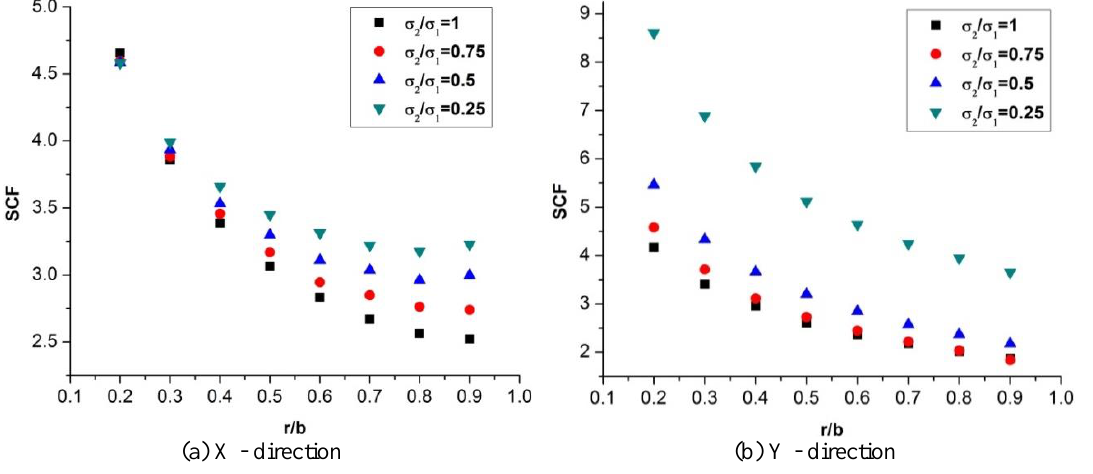
Figure 9. Variation of SCF with loading ratio for b/a = 0.6